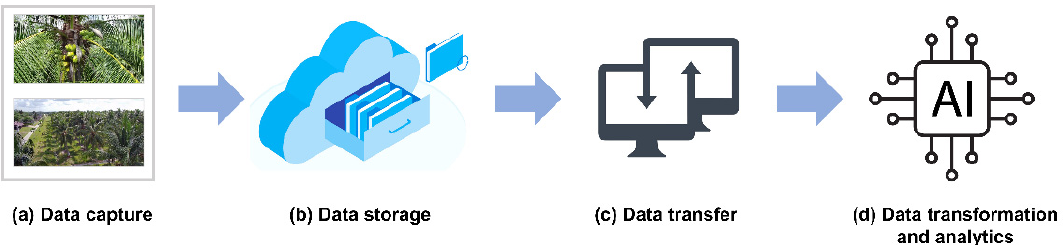
Figure 4. Agricultural data intervention to correct the performance of the farm processors. ( a ) Initial stage of data intervention, data capture is acquisition of data collected from sensors, UAVs, open data, genotype information, biometric sensing, and reciprocal data. ( b ) Data storage phase uses cloud-based platform. ( c ) Data transfer phase integrates cloud, wireless and linked open data network. ( d ) Data transformation and analytics utilizes machine learning platforms which will create automation in selecting, breeding and farm practices.